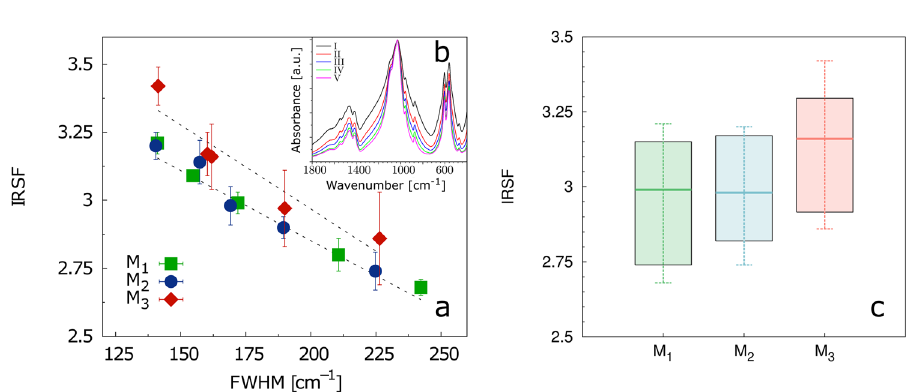
Figure 5. The FTIR spectral differences of phosphate vibrations in the enamel apatite of the five fractions (differ in particle size) of three molar types (M 1 to M 3 ) in the series of tested pigs. ( a ) grinding curves the relation of IRSF against FWHM for three different molar types (each point represents the averaged value of five studied pigs.); ( b ) an example of the measured FTIR spectra used for the plotted parameters (FTIR spectra of five different fractions of second molar (M 2 ) of 26 months old individual showing the variations in FWHM); c) IRSF boxplots of the finest fraction values obtained from all studied